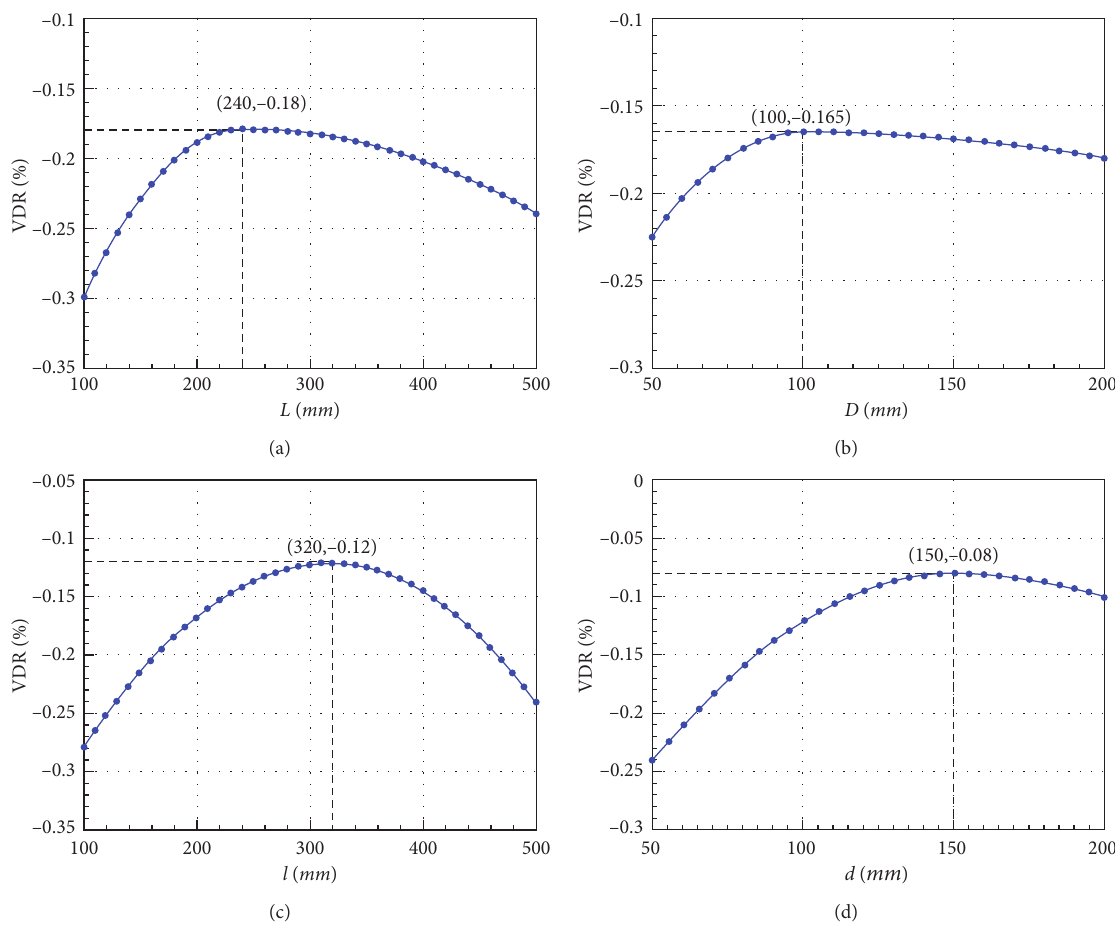
Figure 11: Effect of shield parameters on VDR. (a) L varies from 100mm to 500 mm, D � 75mm, l � 430mm, and d � 100 mm. (b) D varies from 50mm to 200mm, L � 240mm, l � 430mm, and d � 100mm. (c) l varies from 100mm to 500mm, L � 240mm, D � 100mm, and d � 100mm. (d) d varies from 50mm to 200 mm, L � 240 mm, D � 100mm, and l �